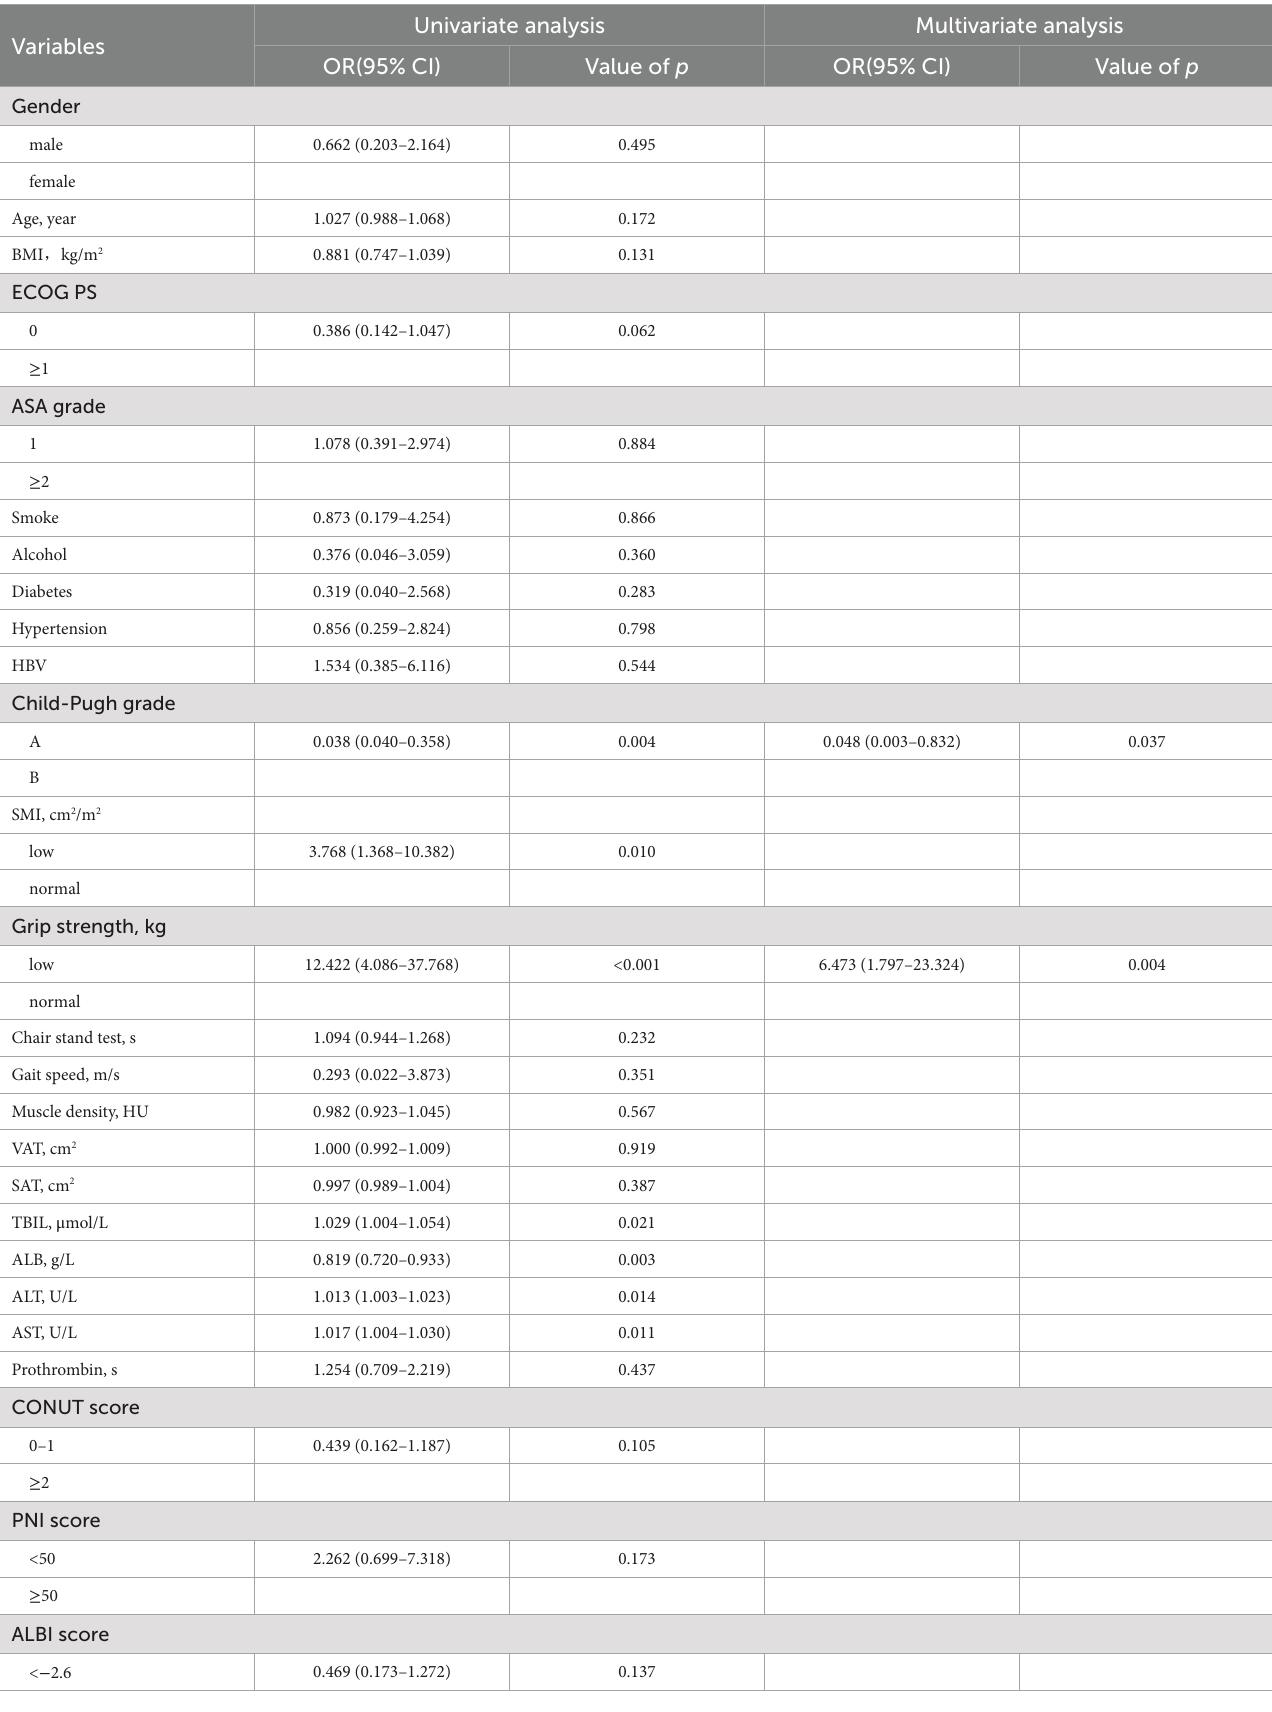
TABLE 3 Univariate and multivariate logistic regression analysis of predictors of major complications (Clavien-Dindo classification III-V).